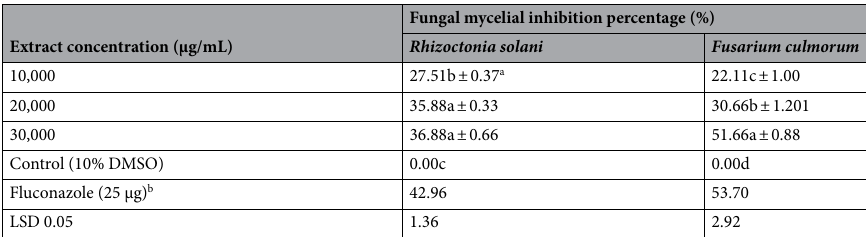
Table 4. Antifungal activity of wood-treated M. oleifera SRRP extract. Means with same letter within the same column are not significantly different according to LSD0.05. a Values are presented as mean ± SE of fungal mycelial inhibition percentages. b Data from our previous work 32 .